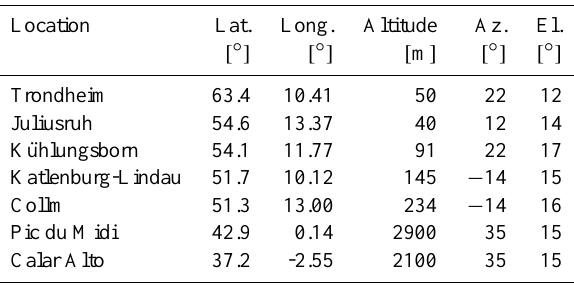
Table 1. Cameras of the IAP NLC Camera Network: latitude, lon- gitude, altitude and pointing of the cameras. The field of view of the cameras is about 54 ◦ horizontally and 40.5 ◦ vertically.